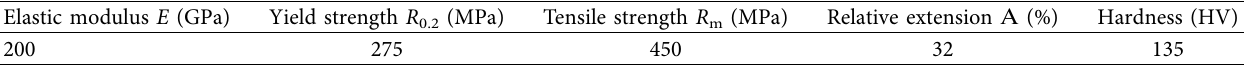
Table 4: Technical data of [24].